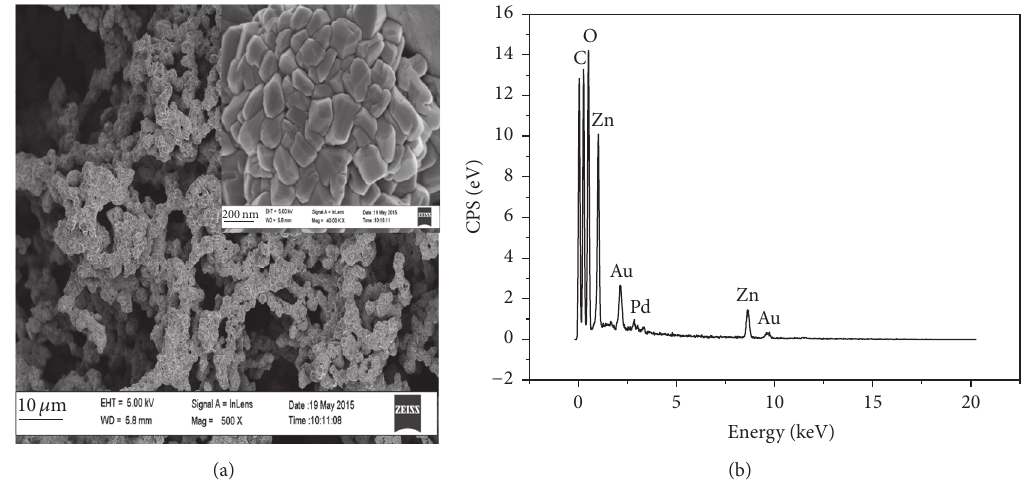
Figure 2: HRSEM analysis for ZnO nanoparticles sample (a) SEM images and (b) EDS spectrum for ZnO.